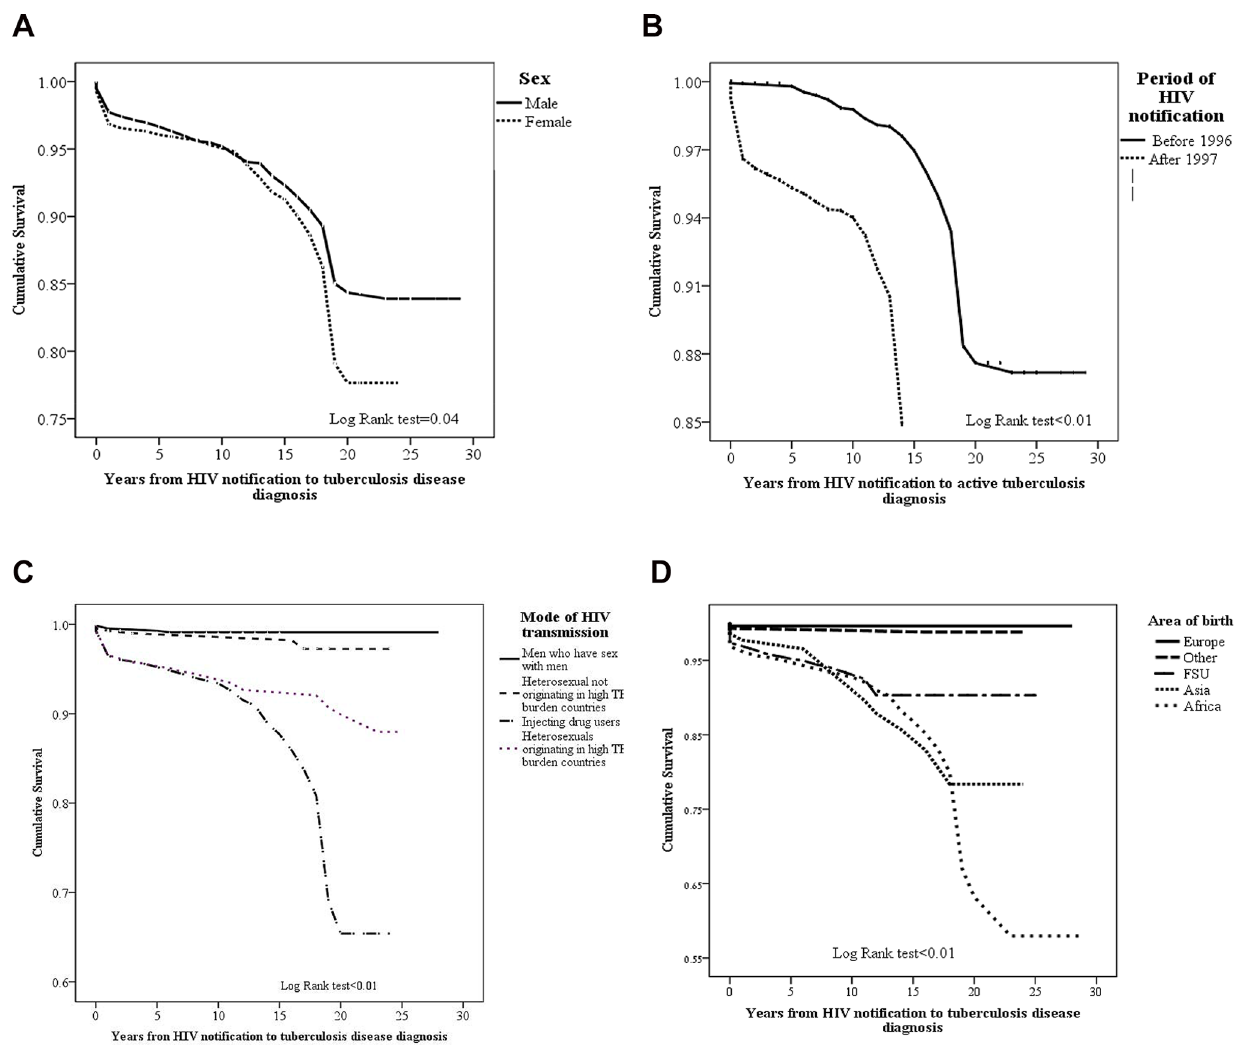
Figure 2. Kaplan-Meier plot for time to tuberculosis in 3942 HIV-infected non-Israeli born citizens, stratified by sex (a). Kaplan-Meier plot for time to tuberculosis in 3942 HIV-infected non-Israeli-born citizens, by period of HIV-diagnosis (b). Kaplan-Meier plot for time to tuberculosis in 3942 HIV- infected non-Israeli-born citizens, by mode of HIV-transmission (c). Kaplan-Meier plot for time to tuberculosis in 3942 HIV-infected non-Israeli-born citizens, by mode of area/country of origin (d). Capitation: The data were retried from the National tuberculosis and HIV/AIDS registries at the Israeli Ministry of Health, Jerusalem, Israel.